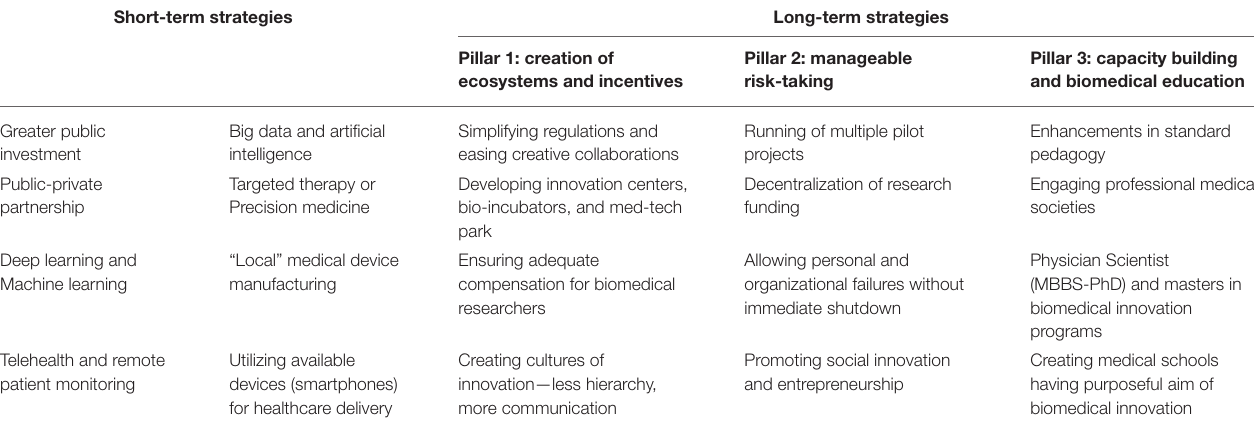
TABLE 1 | Broad action items and strategies for healthcare innovation in India after